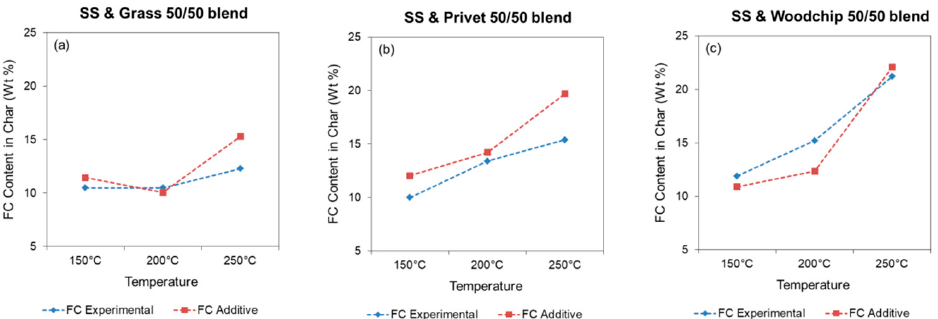
Figure 6. Comparison of experimental and additive levels in the hydrochar of ( a ) FC for SS and grass at 50/50 blend, ( b ) FC for SS and privet hedge at 50/50 blend, and ( c ) FC for SS and woodchip at 50/50 blend.